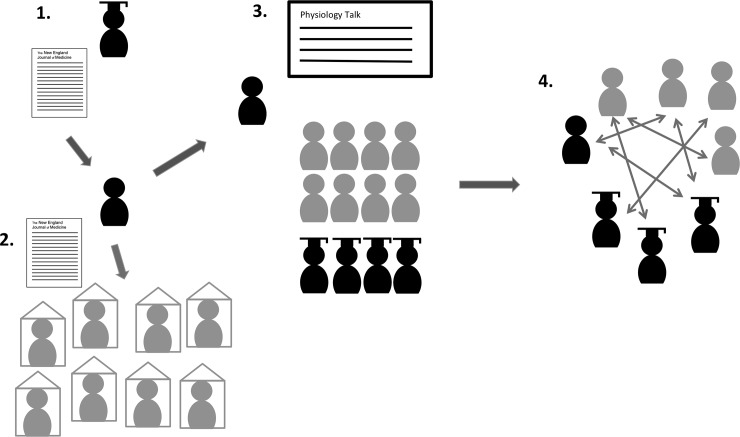
Setting of the peer-led flipped classroom concept.1. Education coordinator sends article to peer-teacher, 2. Faculty members prepare learning material individually prior to the session. 3. Peer teaching during the session. 4. Interactive peer-led discussion is held to answer remaining questions, clarify concepts, and trigger critical thinking.